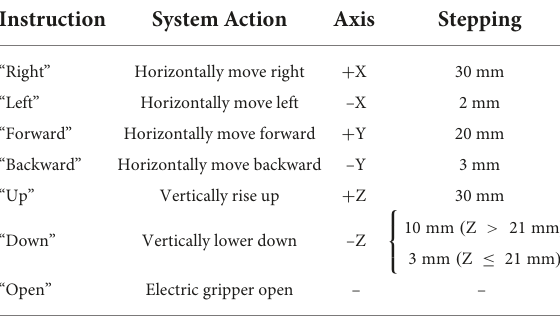
TABLE 1 The instruction list of AUBO-i5